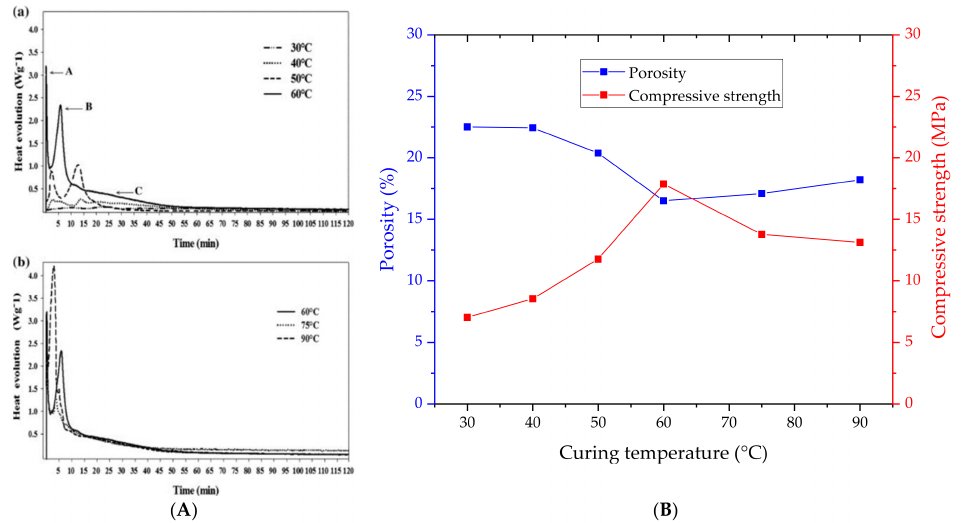
Figure 11. ( A ) DSC thermograms of MK-based geopolymer cement as a function of curing temperature: ( a ) 30 ◦ C, 40 ◦ C, 50 ◦ C, and 60 ◦ C and ( b ) 60 ◦ C, 75 ◦ C, and 90 ◦ C. ( B ) Effect of curing regimes on porosity and mechanical strength. Reprinted with permission from Ref. [55]. Copyright 2011